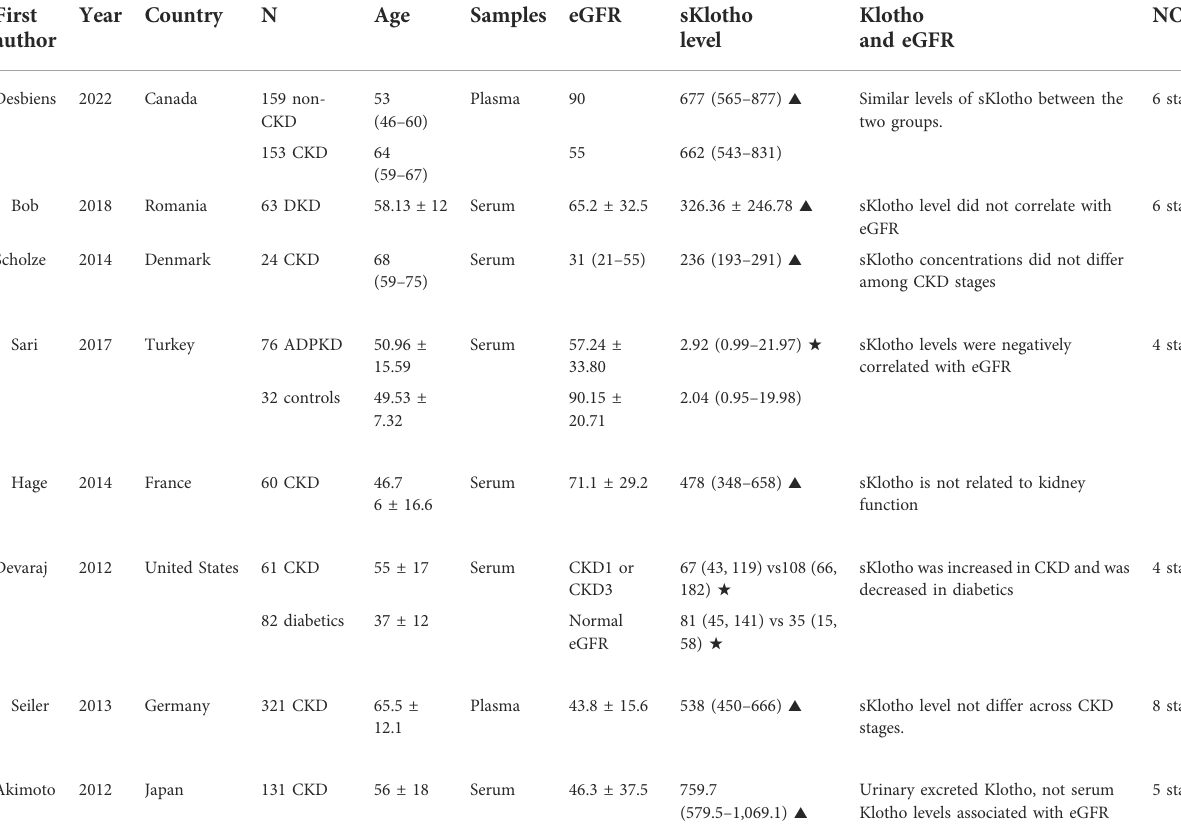
TABLE 1 Characteristics of the negative observational studies regarding the relationship of Klotho with kidney